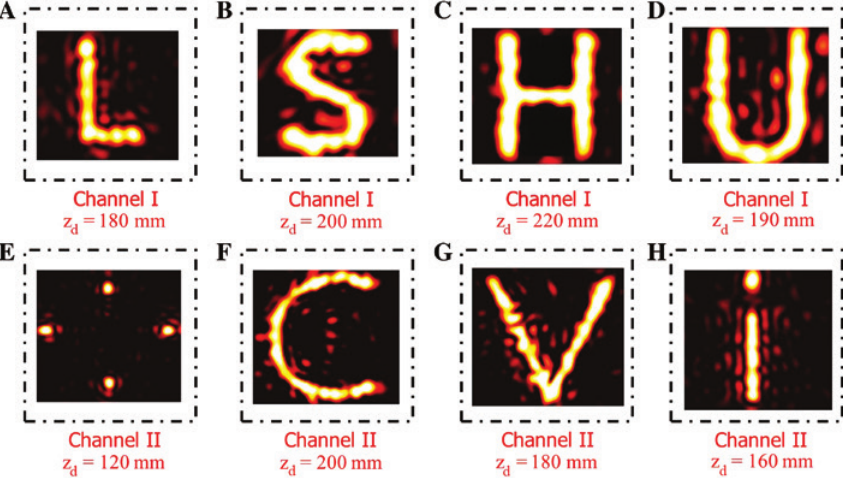
Figure 5: The theoretical results of different sets of holographic images projected at the low-frequency (top row) and high-frequency (bottom row) channels.